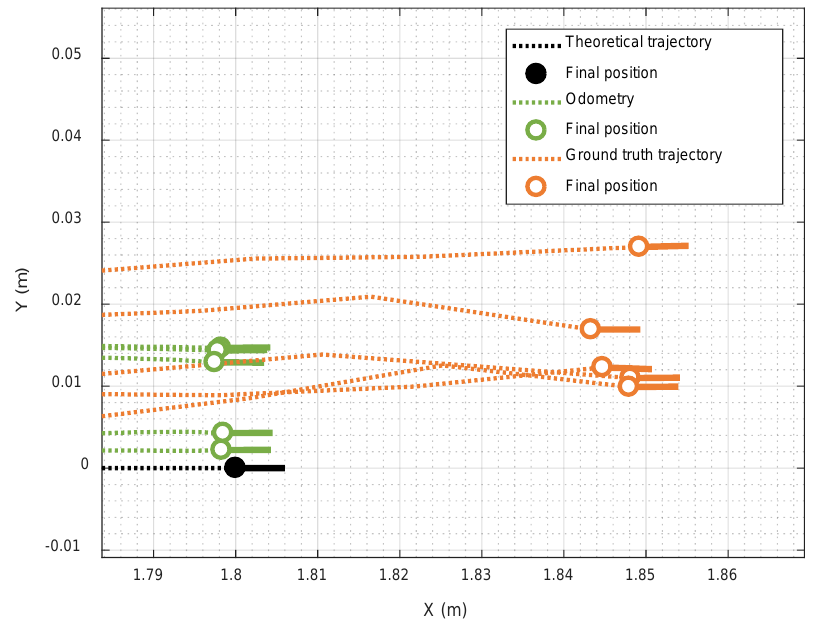
Figure 7. Planned trajectory (back dotted line) zoomed at the planned ending position and orientation of the mobile robot (black point and line); measured ground truth trajectories (orange dotted line) detailing the final position and orientation of the mobile robot (orange circle and line); and measured odometry trajectory (green dotted line) detailing the ending position and orientation of the mobile robot (green circle and line).